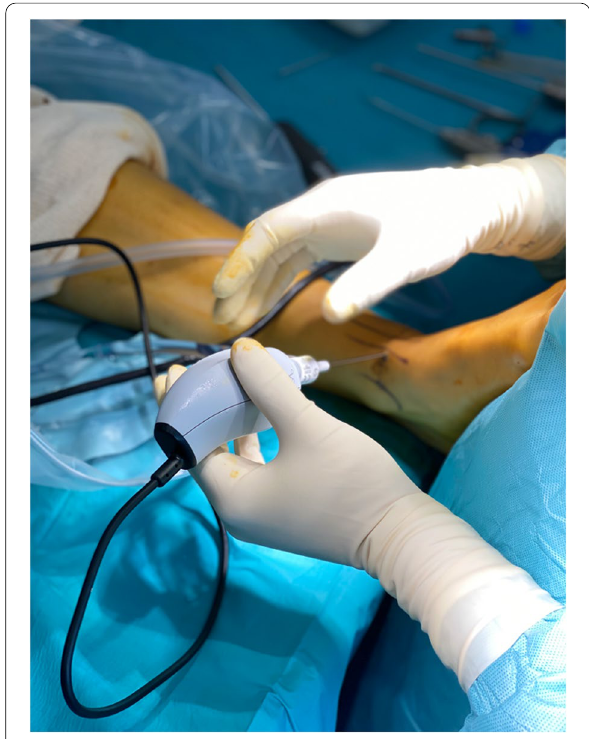
Fig. 7 Needle arthroscope